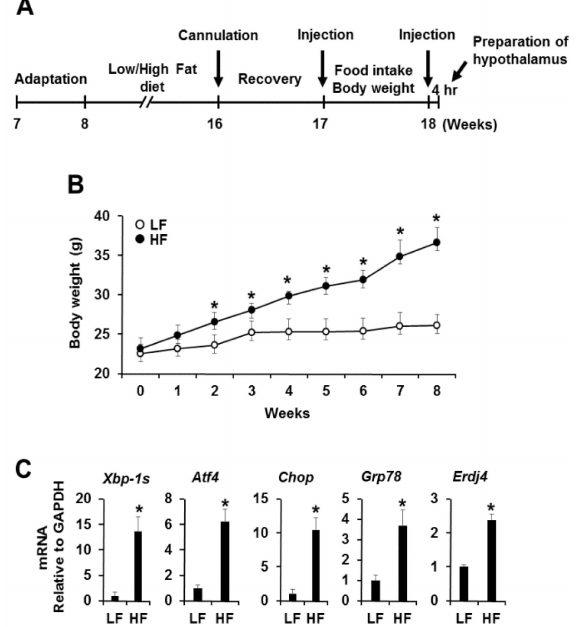
Figure 1. Increased hypothalamic ER stress in mice fed a high-fat diet. ( A ) Experimental timeline of the experimental procedure; ( B ) Time dependence of body weight in low fat and high-fat-diet-induced mice. At 8 weeks of age, mice fed a high-fat diet showed a 43% increase in body weight compared with those fed a low-fat diet. The results are means ˘ SDs ( n = 10); * p values of < 0.05 indicate significant difference from low-fat diet-induced mice; ( C ) mRNA expression levels of ER stress responsive markers in low fat and high-fat-diet-induced mice. mRNA expression levels of ER stress responsive markers were dramatically upregulated in high-fat-diet-induced obese mice. The results are means ˘ SDs ( n = 10); * p values of < 0.05 indicate significant difference from low-fat-diet-induced mice. LF, low-fat diet. HF, high-fat